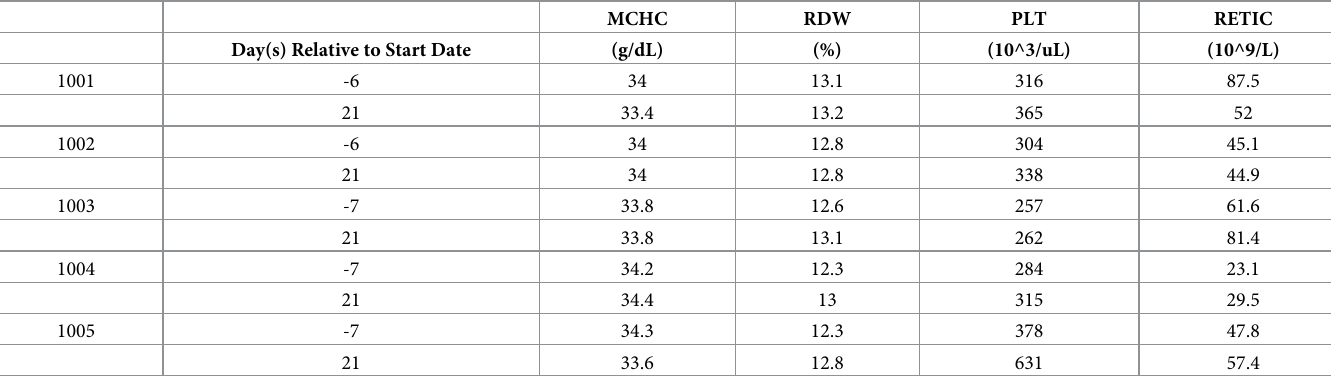
Table 3. Hematology reporting for each animal for MCHC, RDW, PLT, and RETIC.